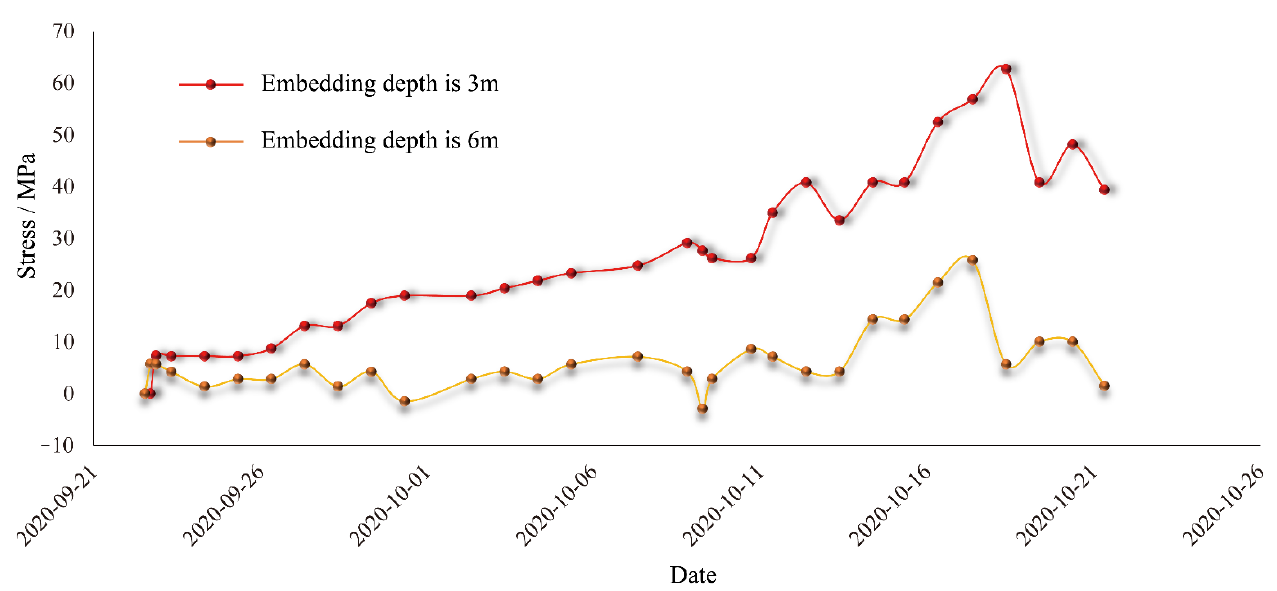
Figure 13. Monitoring data of the bolt stress meter (stake 0+457 m).